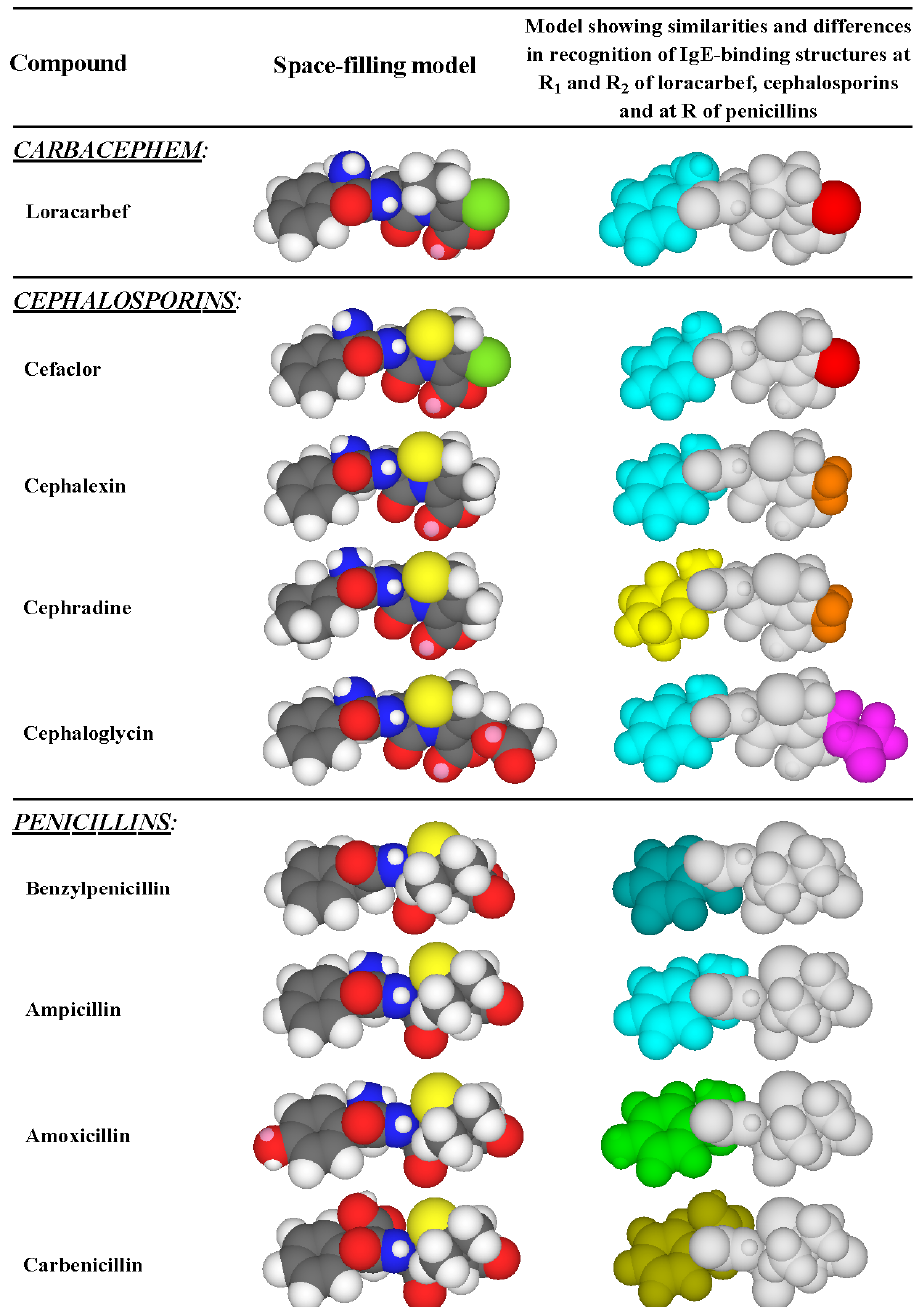
Figure 8. Side chain reactivity (highlighted in color) of some penicillins, cephalosporins and the carbacephem, loracarbef, with IgE antibodies in the sera of patients allergic to the dicyclic β -lactams. R1 side chains: aminobenzyl group (light blue); aminocyclohexadienyl group (yellow); benzyl group (dark blue); hydroxyaminobenzyl group (green); carboxybenzyl group (yellow-green). R2 side chains: chlorine atom (red); methyl group (orange); ester group -CH OCOCH 2 3